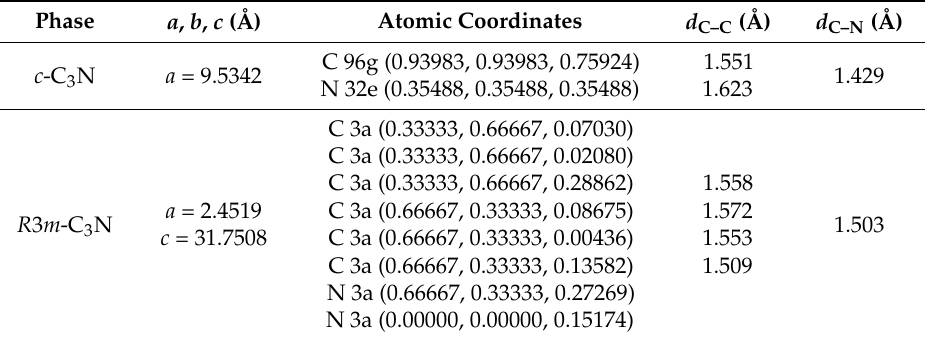
Table 1. The calculated equilibrium structural parameters of c -C 3 N and R 3 m -C 3 N at ambient pressure.